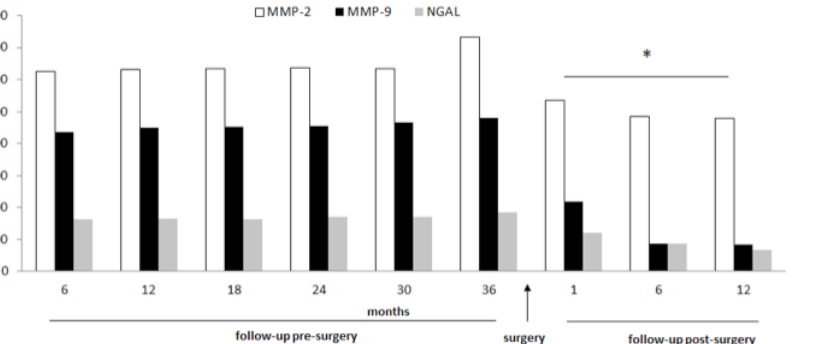
Figure 2: Plasma levels of MMP-2, MMP-9 and NGAL, measured through ELISA test in patients during the follow-up before and after the surgery. *P<0.01 post-surgery vs pre-surgery.